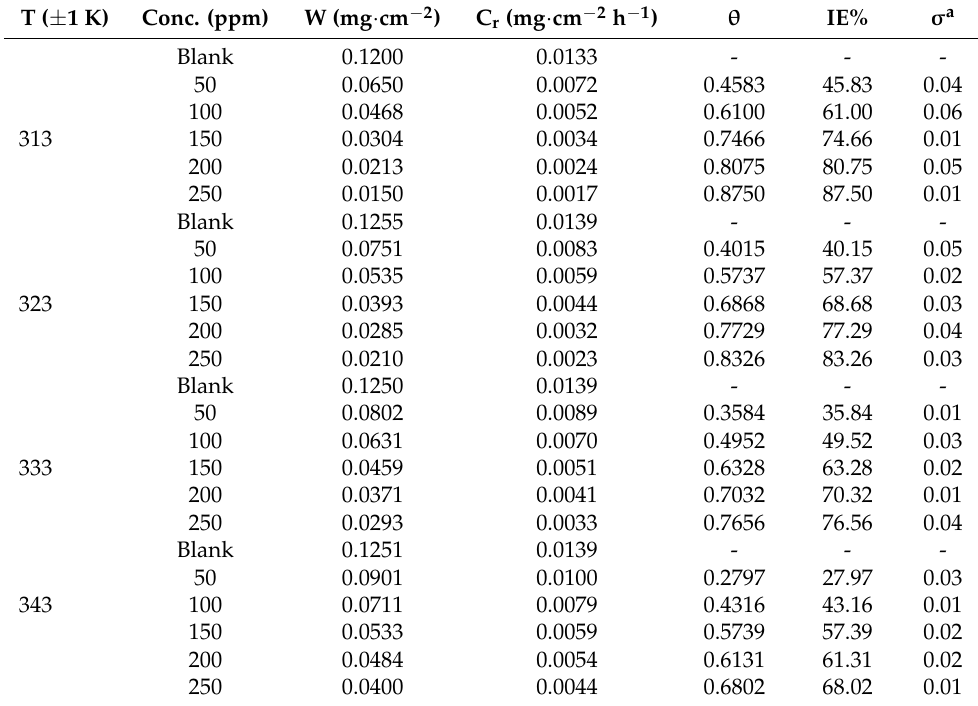
Table 2. IE of T. aralioides for various concentrations against MS in 1M HCl at various temperatures by WL